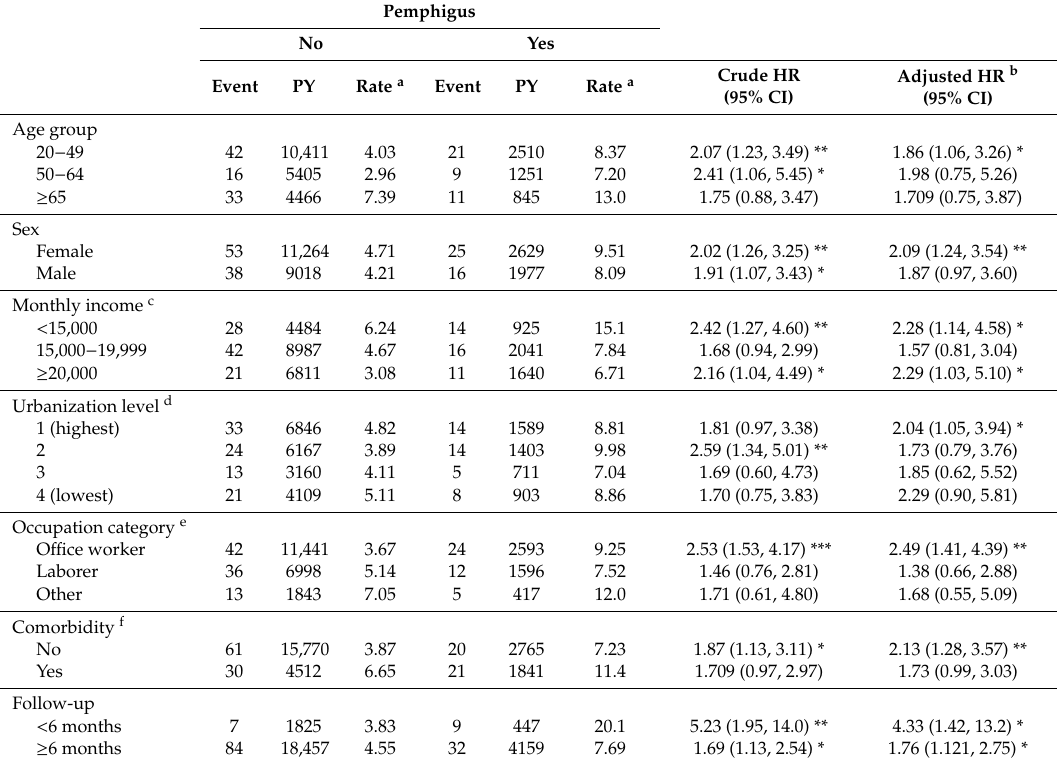
Table 3. Incidences and hazard ratios of depression between individuals with and without